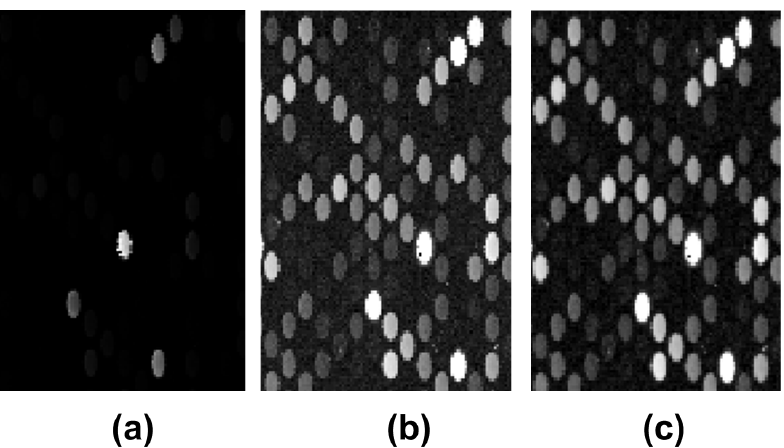
Figure 2. Image preprocessing techniques applied to the AT 218398 microarray image: ( a ) original image, ( b ) logarithmically transformed and normalized image, ( c ) top-hat transformed